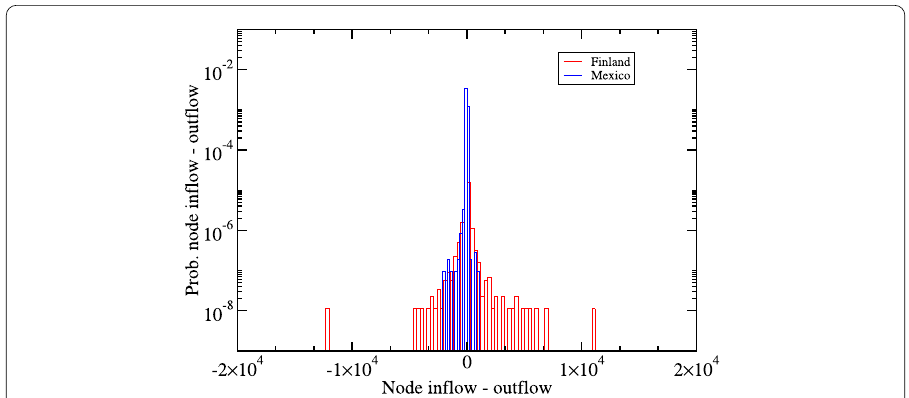
Figure 5 Distribution of the difference between flow of workers into and out of a firm. In this plot, there are over 49,000 firms for Mexico and close to 300,000 firms for Finland